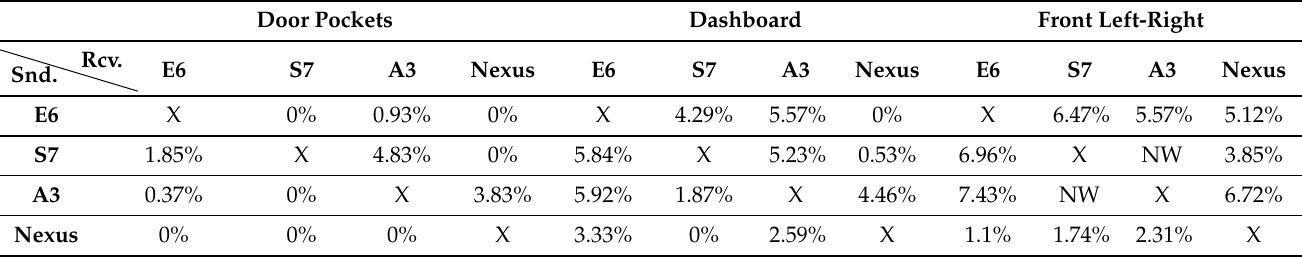
Table 7. BER for in-vehicle experiments (16.7–20 KHz